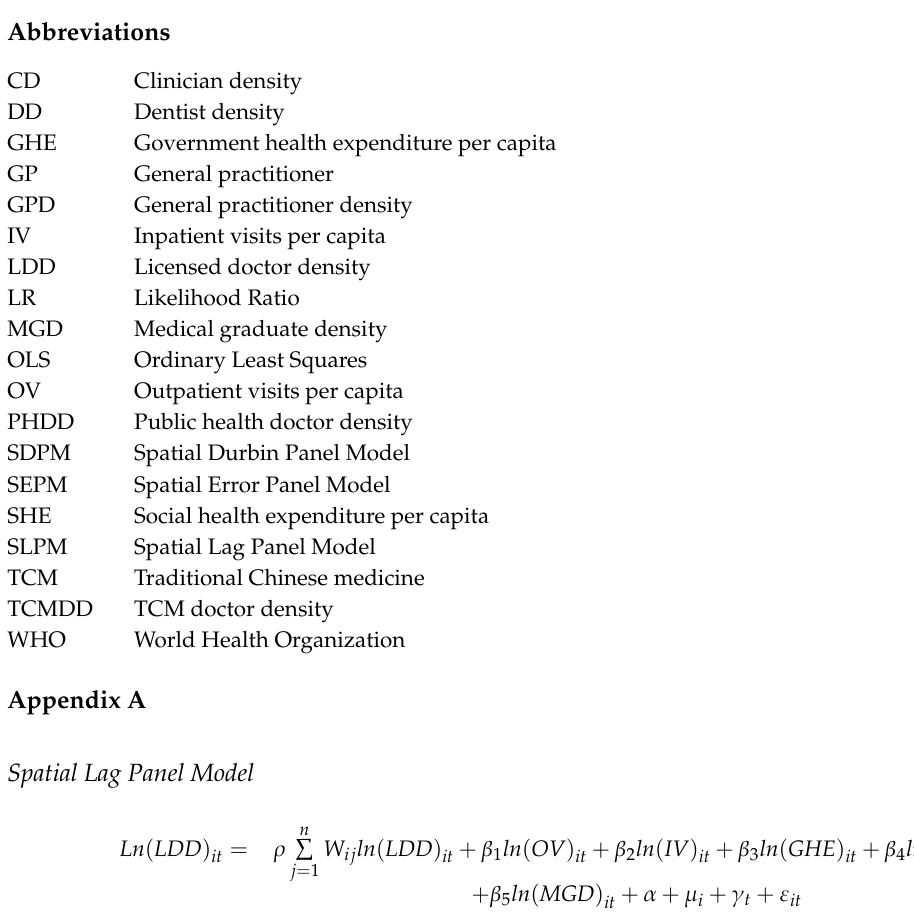
Figure S1: The administrative divisions of China, Table S1: The original data of this study, Table S2: Estimation results of spatial panel econometric models for clinician density, Table S3: Estimation results of spatial panel econometric models for traditional Chinese medicine doctor density, Table S4: Estimation results of spatial panel econometric models for dentist density, Table S5: Estimation results of spatial panel econometric models for public health doctor density, Table S6: Estimation results of spatial panel econometric models for general practitioner